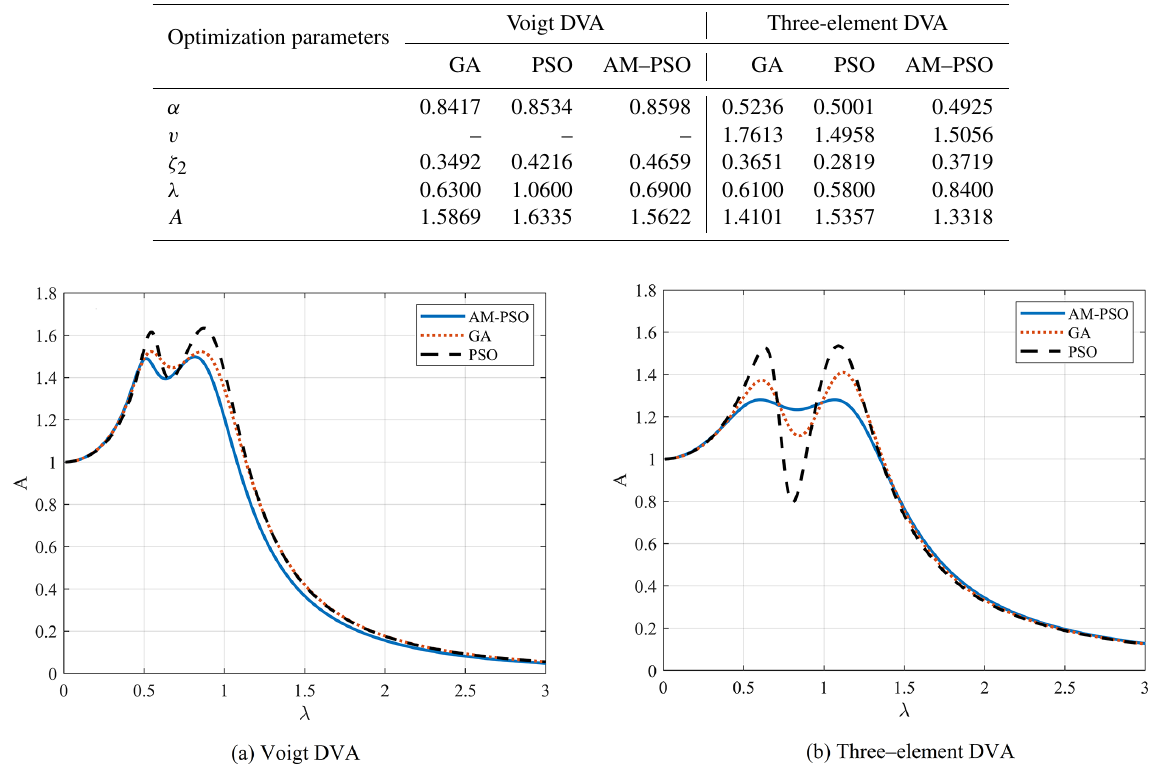
Figure 5. Comparison of optimization performance. (a) Voigt DVA. (b) Three-element